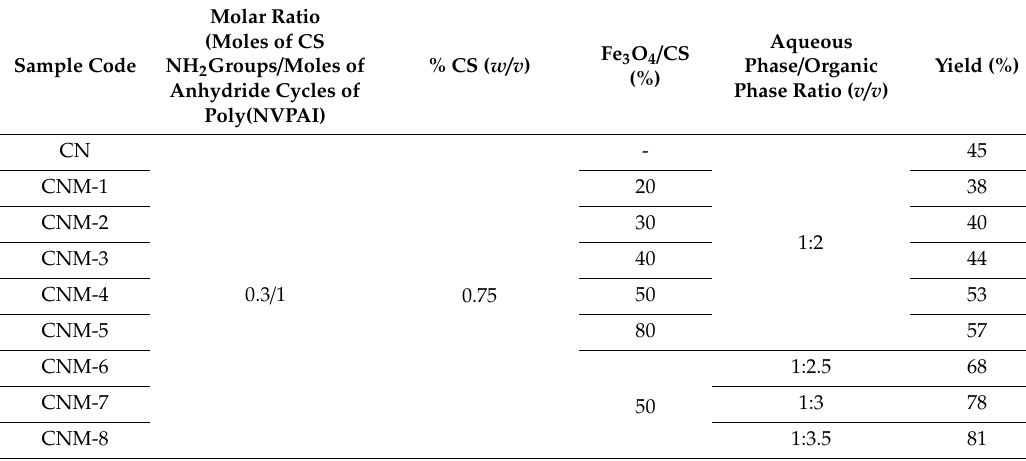
Table 1. Experimental program and codification of synthesized samples (CN- represent non-magnetic nanocapsules and CNM represent magnetic nanocapsules).